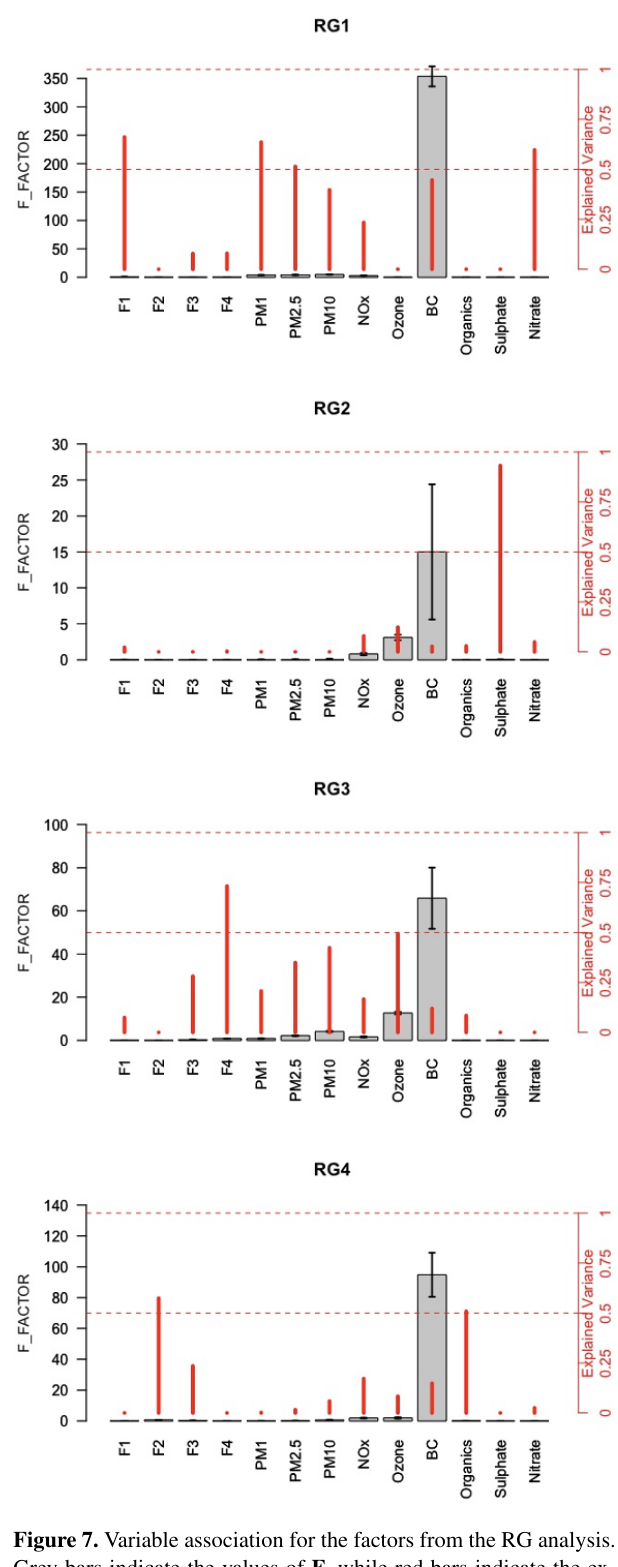
Figure 7. Variable association for the factors from the RG analysis. Grey bars indicate the values of F , while red bars indicate the ex- plained variations for each variable.